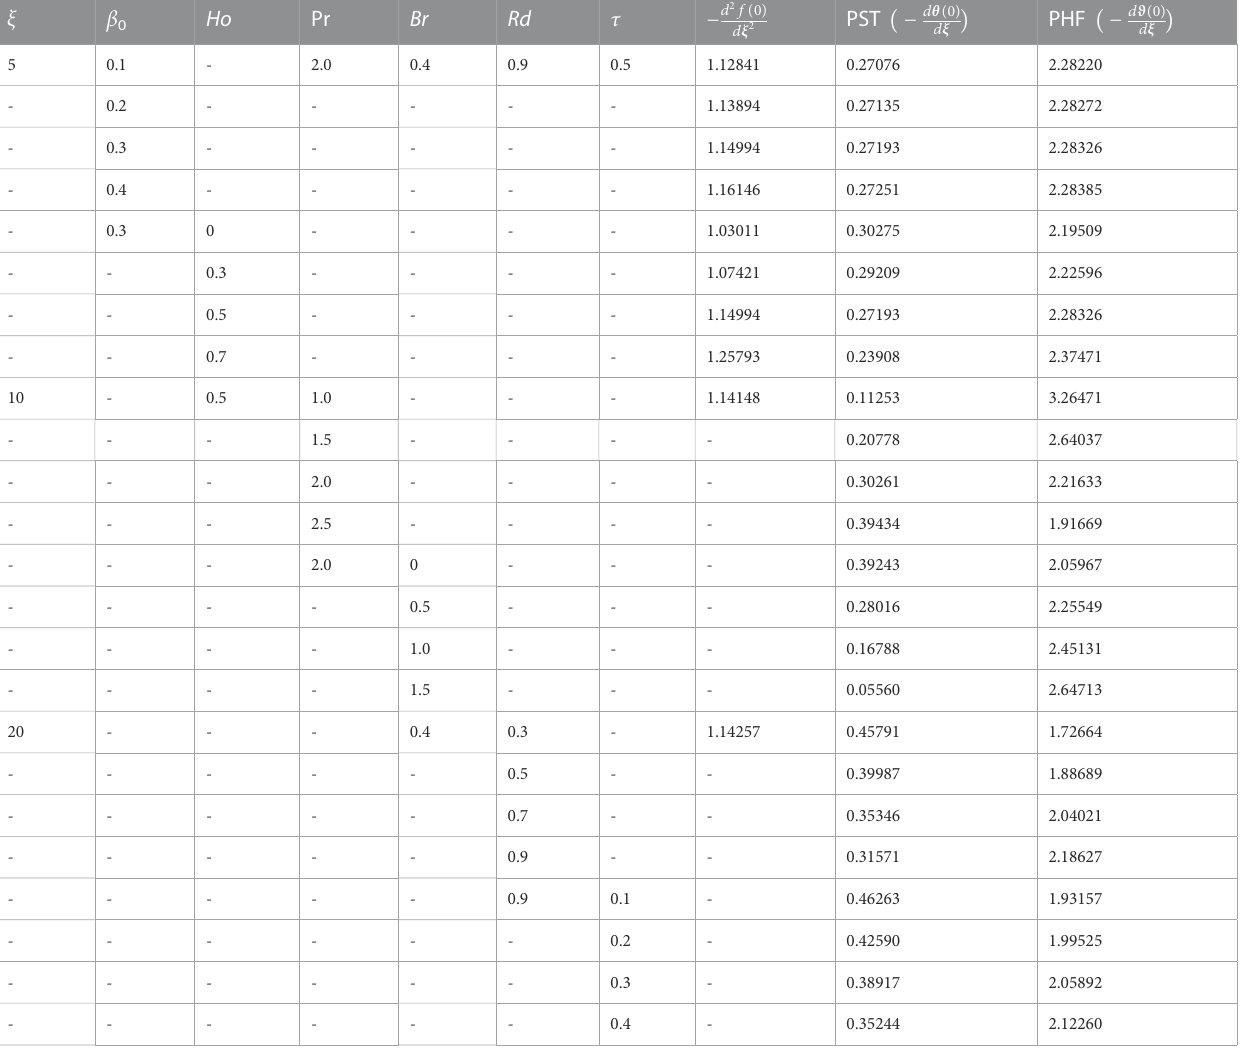
TABLE 2 Numerical values of the surface rate of heat transfer for various ξ , β 0 , Ho , Pr , Br , Rd , and τ when m